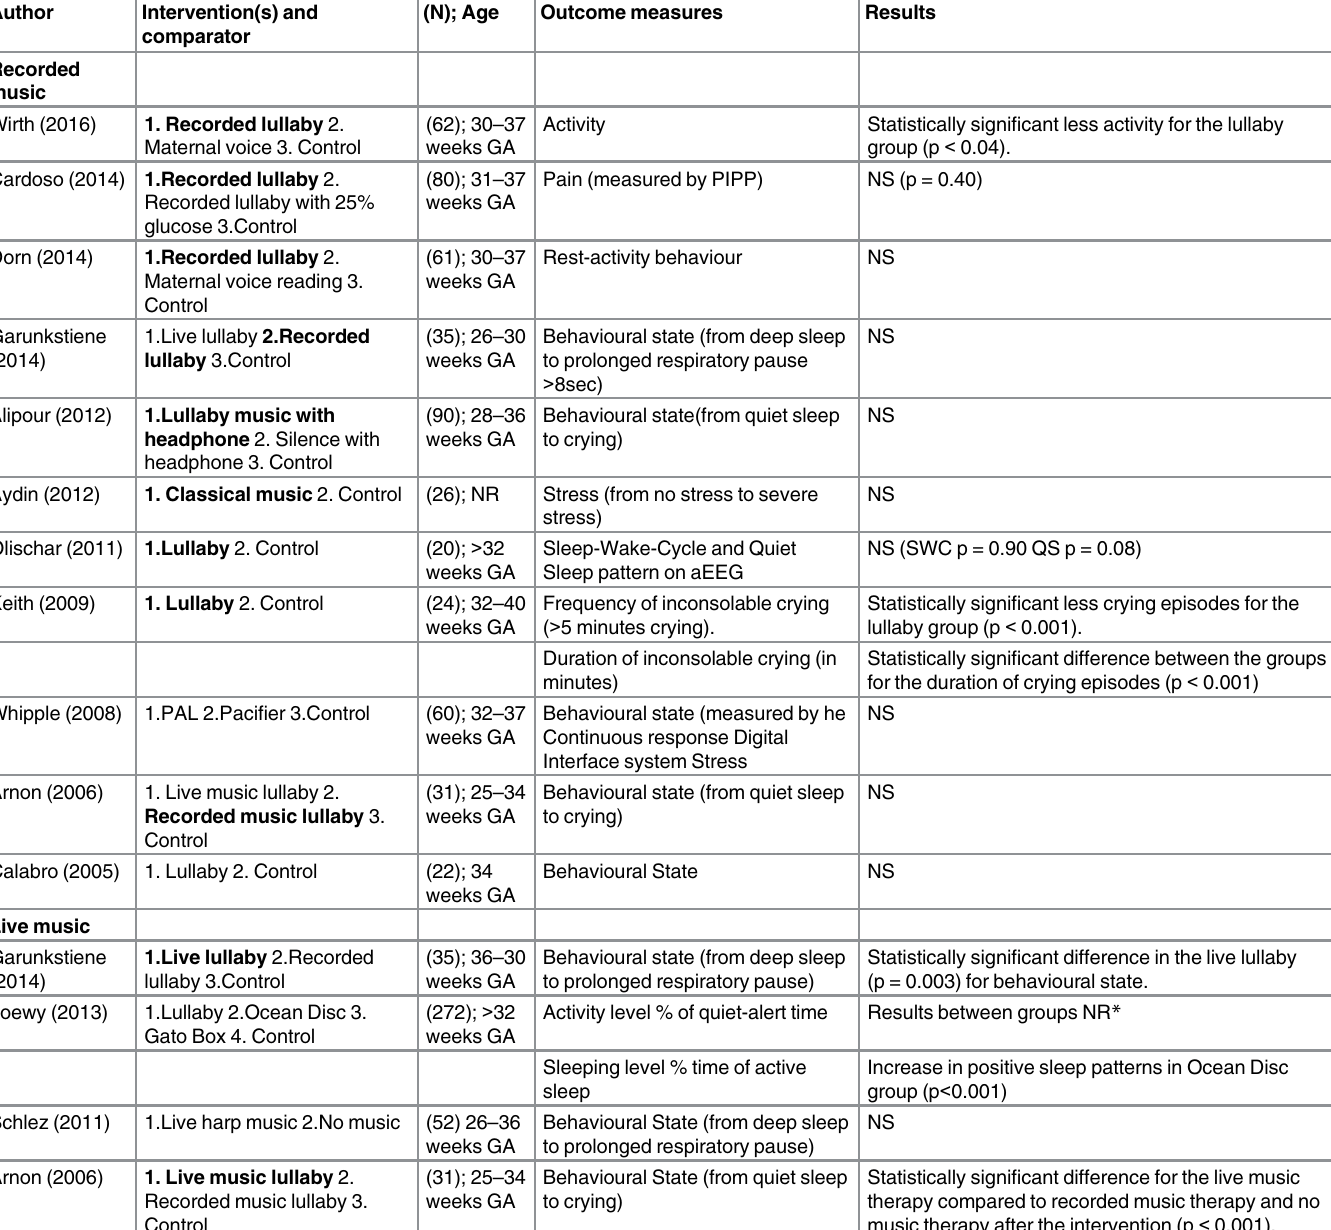
Table 5. Results of the effects of music on behavioural state , relaxation outcomes and pain . Results of the effects of music on behavioural state, relax- ation outcomes and pain between the intervention and control groups. Tabulated results compare the experimental intervention in boldface to the control